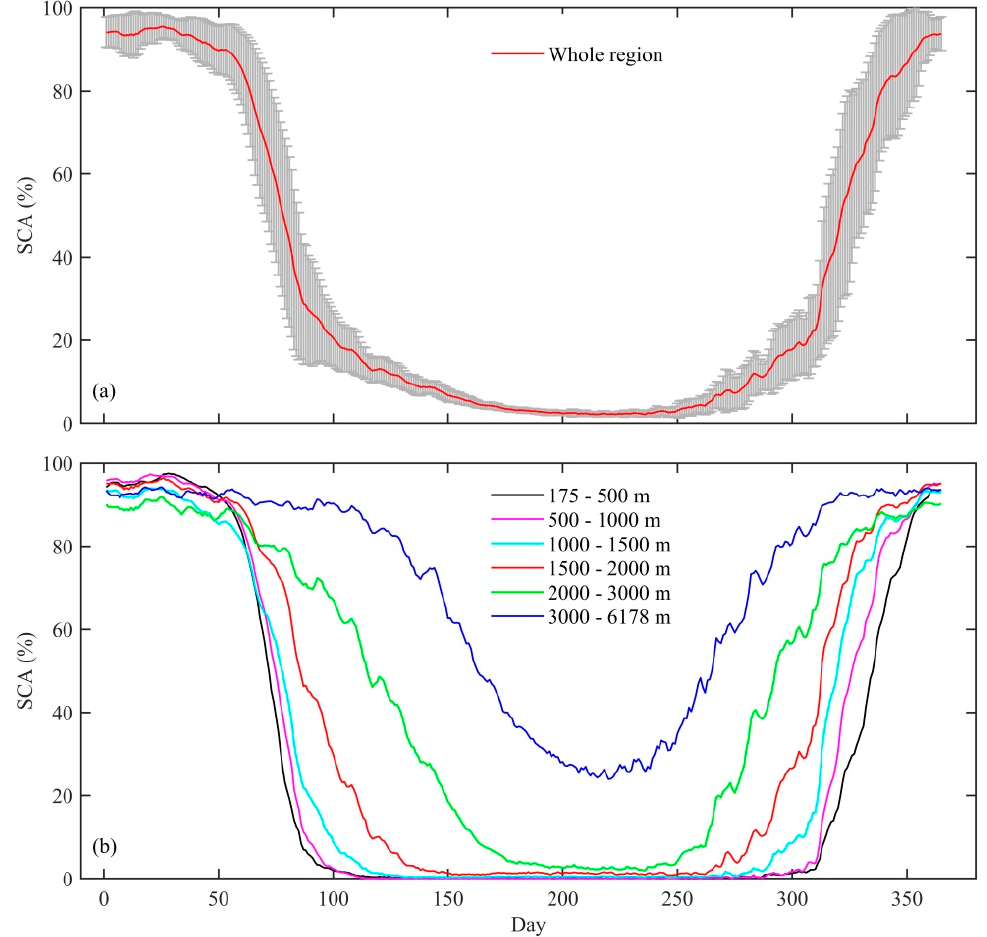
Figure 7. Intra-annual dynamic changes in the snow cover area (SCA) for the whole region ( a ) and for six altitudinal zones ( b ) during 2001–2018.